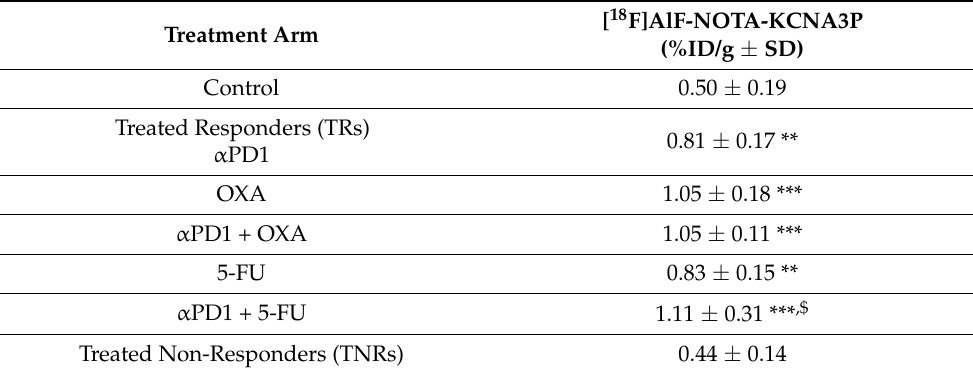
Table 1. Table displaying [ 18 F]AlF-NOTA-KCNA3P tumour uptake in each treatment arm. Data are represented as %ID/g ± S.D. comparing treated responders from each treatment arm (TR) to treated non-responders (TNRs) ( n = 6–10 mice/group; ** p < 0.01; *** p < 0.001 comparing TRs in each treatment arm to TNRs; $ p < 0.05 comparing α PD1 + 5-FU TRs to 5-FU